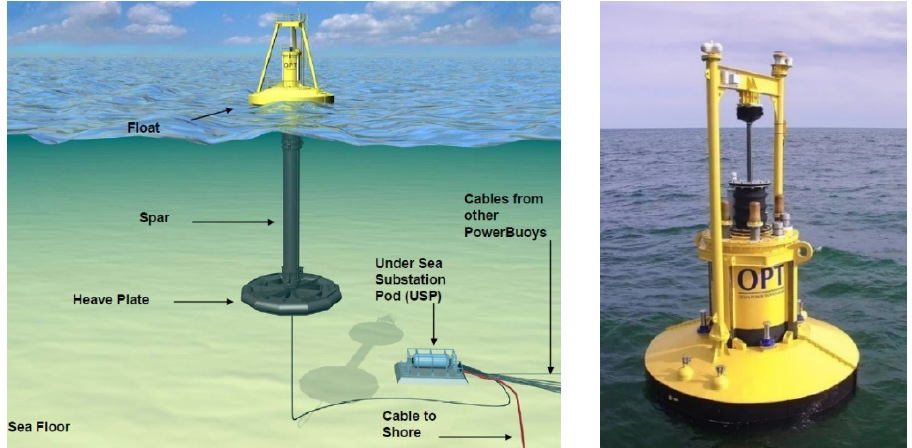
Figure 19. Rendering view ( left ) (Reproduced with permission 5139260046167 from [32], Elsevier, 2010) and external view ( right ) of Wavebob (Reproduced with permission 5139260268553 from [72], Elsevier, 2016).